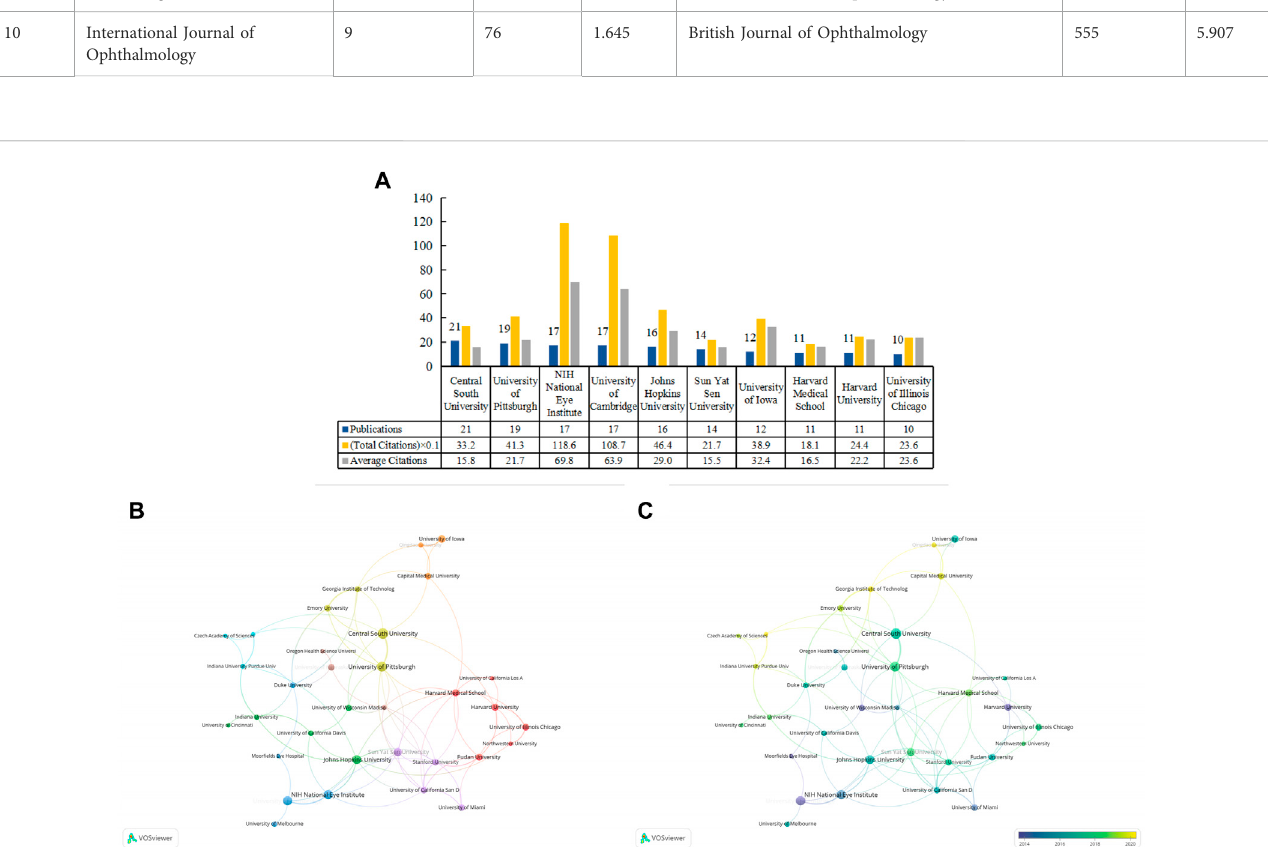
FIGURE 3 The top 10 proli fi c institutions and cooperative relationships between institutions in work on the applications of stem cells for glaucoma treatment and research. (A) The numbers of publications, total citations, and average citations in the top 10 institutions. (B) The cooperative network visualization map of institutions working on applications of stem cells for glaucoma treatment and research. Node size indicates the number of publications, and the thickness of the link positively correlates with the cooperation strength. (C) The cooperative network overlay visualization map of institutions for the application of stem cells for glaucoma treatment and research. Blue represents the early research phase, and yellow represents the recent period.